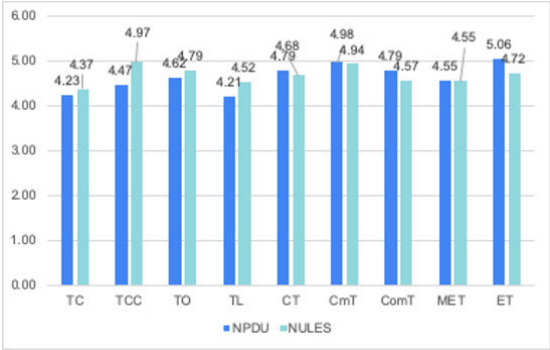
Figure 6. Comparison of the various trust domains between students of the NPDU and the